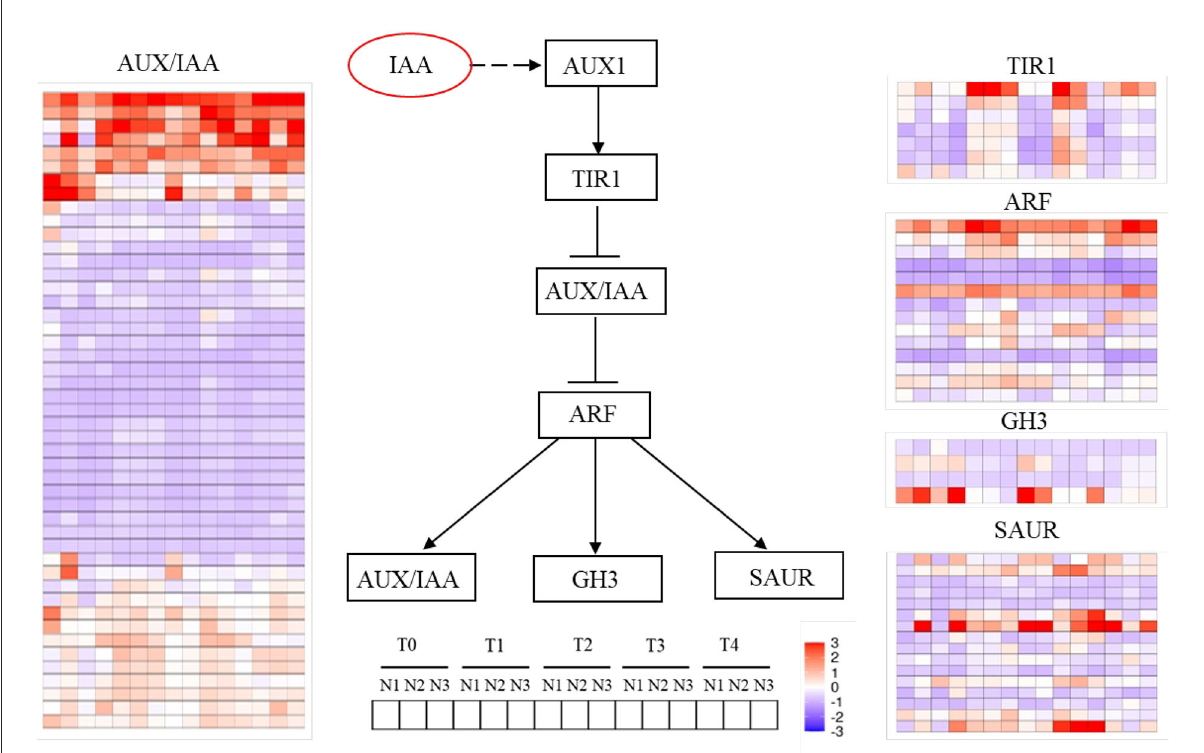
FIGURE4 Changes of genes involved in auxin signaling transduction at T0, T1, T2, T3, and T4 sampling stages under low N (N1), normal N (N2), and high N (N3) rates. ARF , Auxin response factor ; AUX1 , Auxin influx carrier 1 ; AUX/IAA, Auxin responsive protein ; TIR1, Transporter inhibitor response 1 . Color bars represented the trends of expression levels after centralization and standardization by the R programming language and red color represents higher expression, while purple represents lower expression